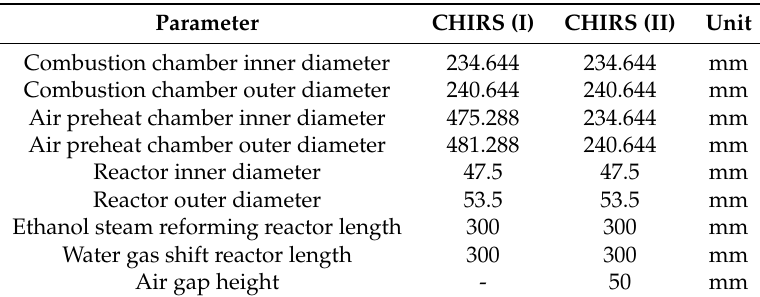
Table 1. CHIRS (I) and CHIRS (II) dimensions.